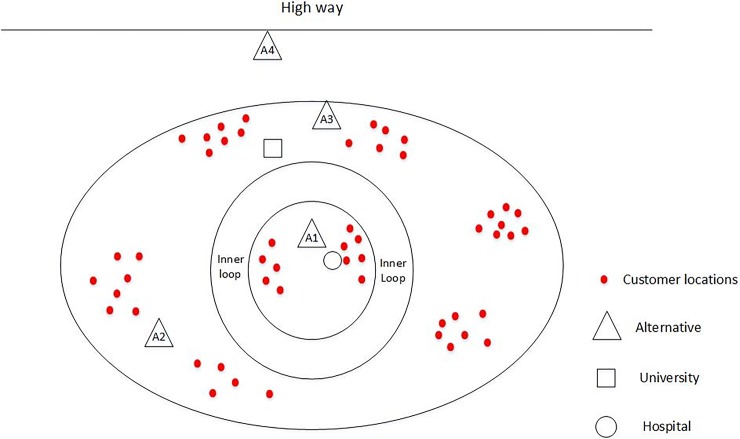
Potential locations for the urban DCs.